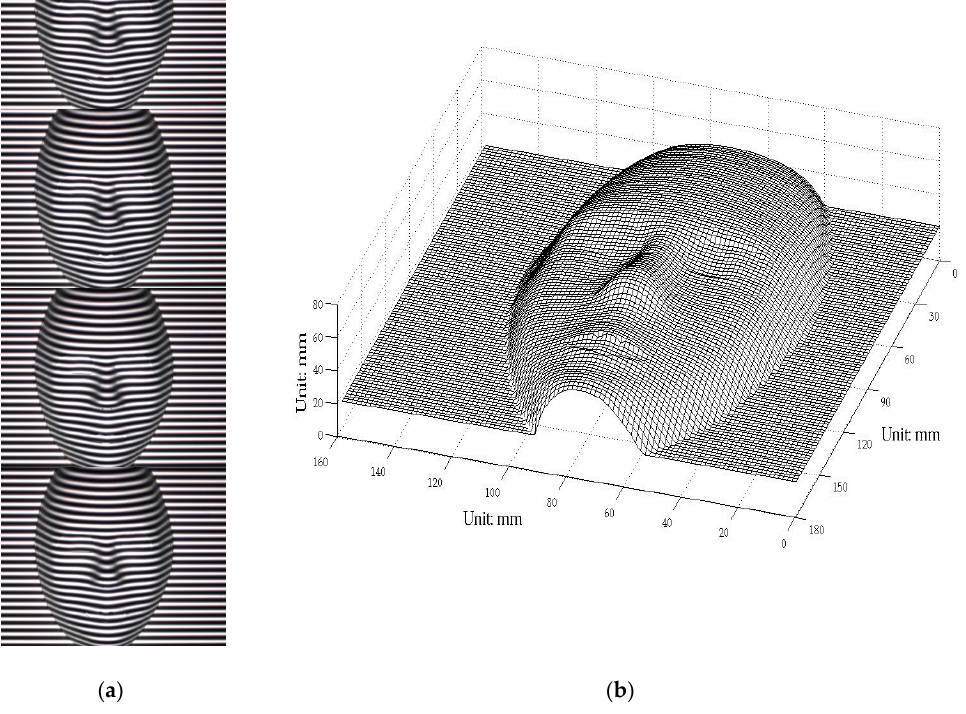
Figure 6. ( a ) Captured four fringes with a phase-shifting value of π /4 modulated by the model surface; ( b ) rebuilt 3D model profile based on phase measuring profilometry (PMP).